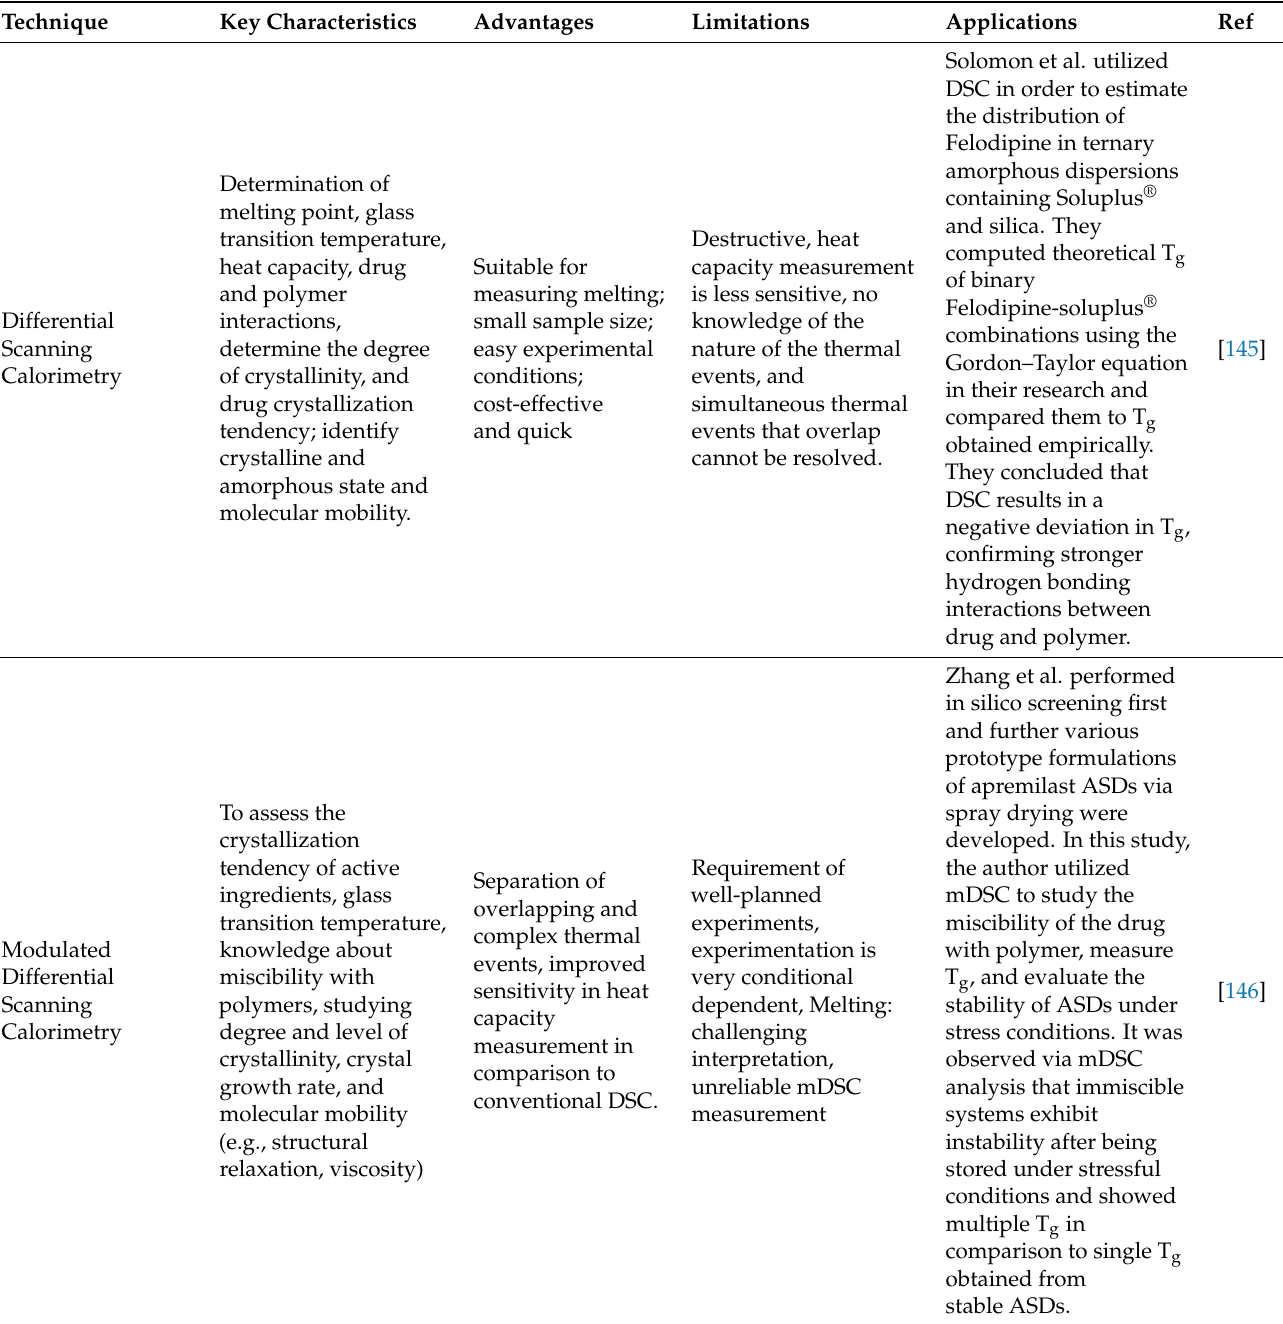
Table 2. List of conventional analytical techniques used in the characterization of